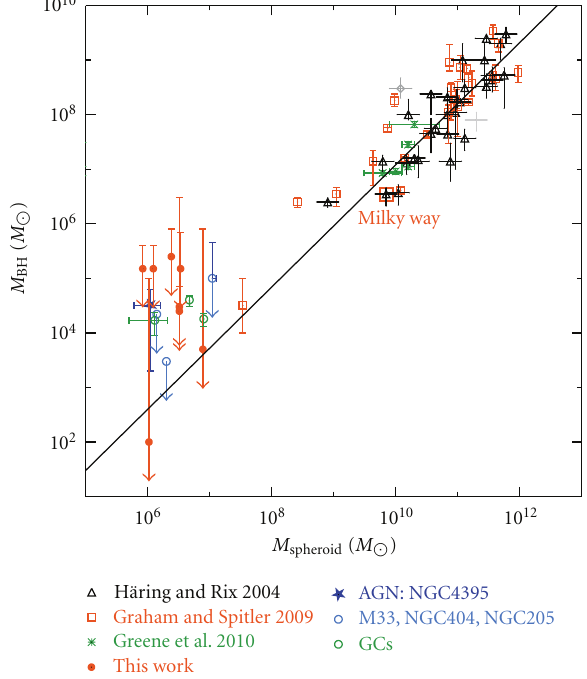
Figure 3: The BH mass versus the spheroid mass (bulge, GC, NC). We plot the objects as listed in the text. The line indicates the best- fitting relation of H¨aring and Rix